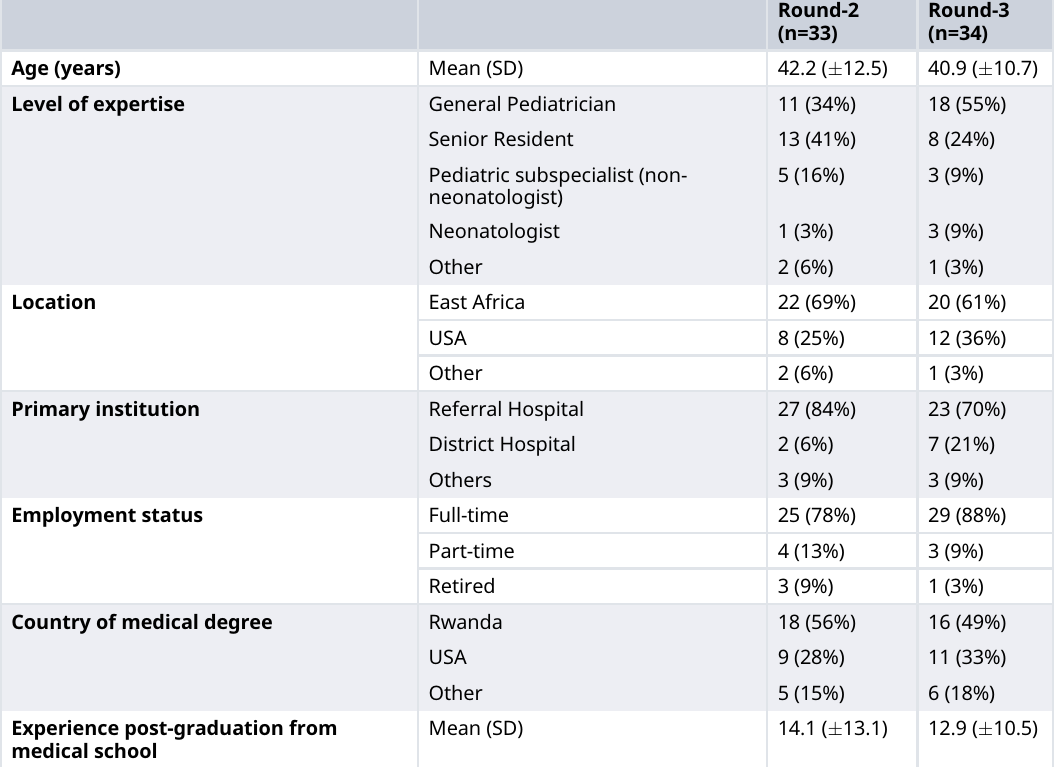
Table 2. Baseline characteristics of participants of Round-2 and Round-3 of Delphi